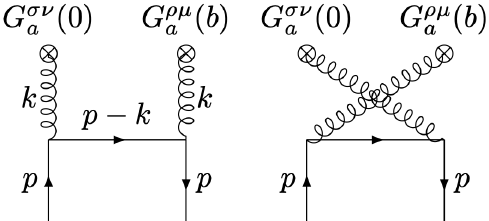
Figure 5 . Mixing of quark TMDs into gluon TMDs at lowest order, i.e. O ( α s ) . The Lorentz indices correspond to the gluon TMD operator, while p is the momentum of the external on-shell